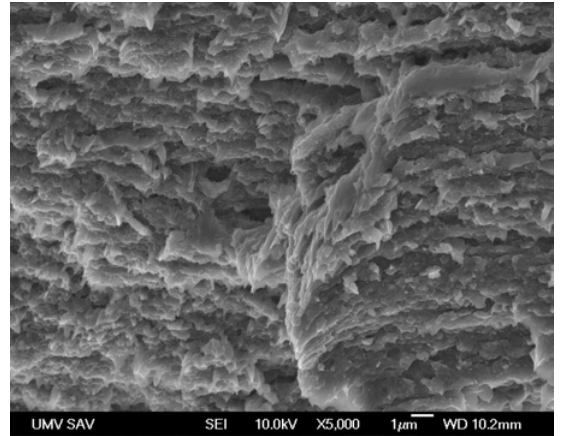
Figure 15. The fracture of Al-4 vol.% Al 4 C 3 after SP creep, direction 60°.